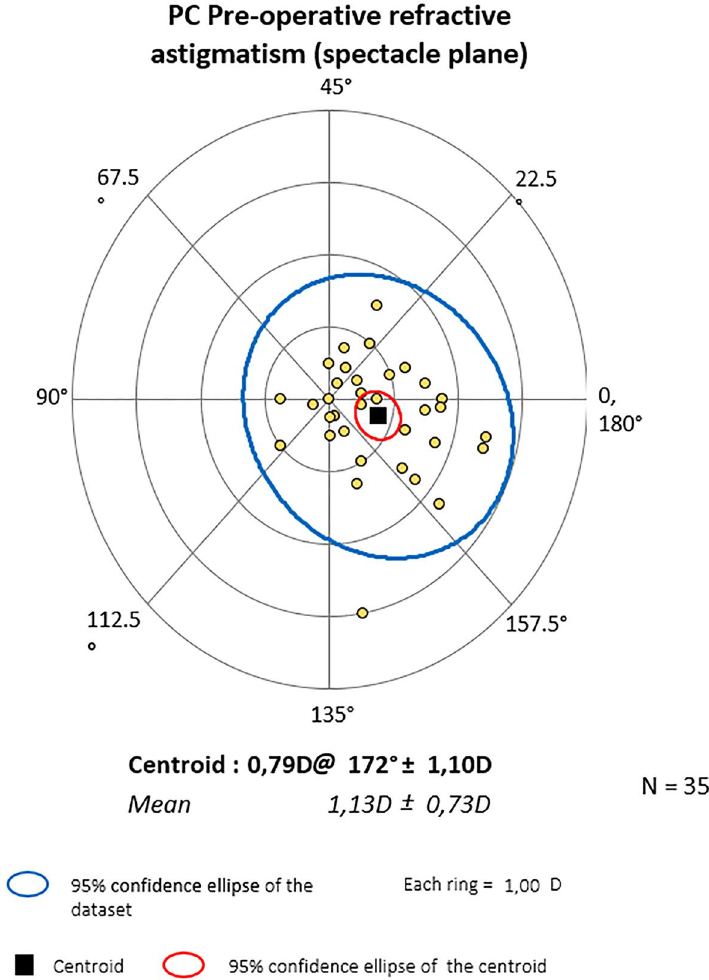
Figure 3. Preoperative astigmatism on the double angle plot in PC. The trend is ATR. The yellow dots represent a single subject’s